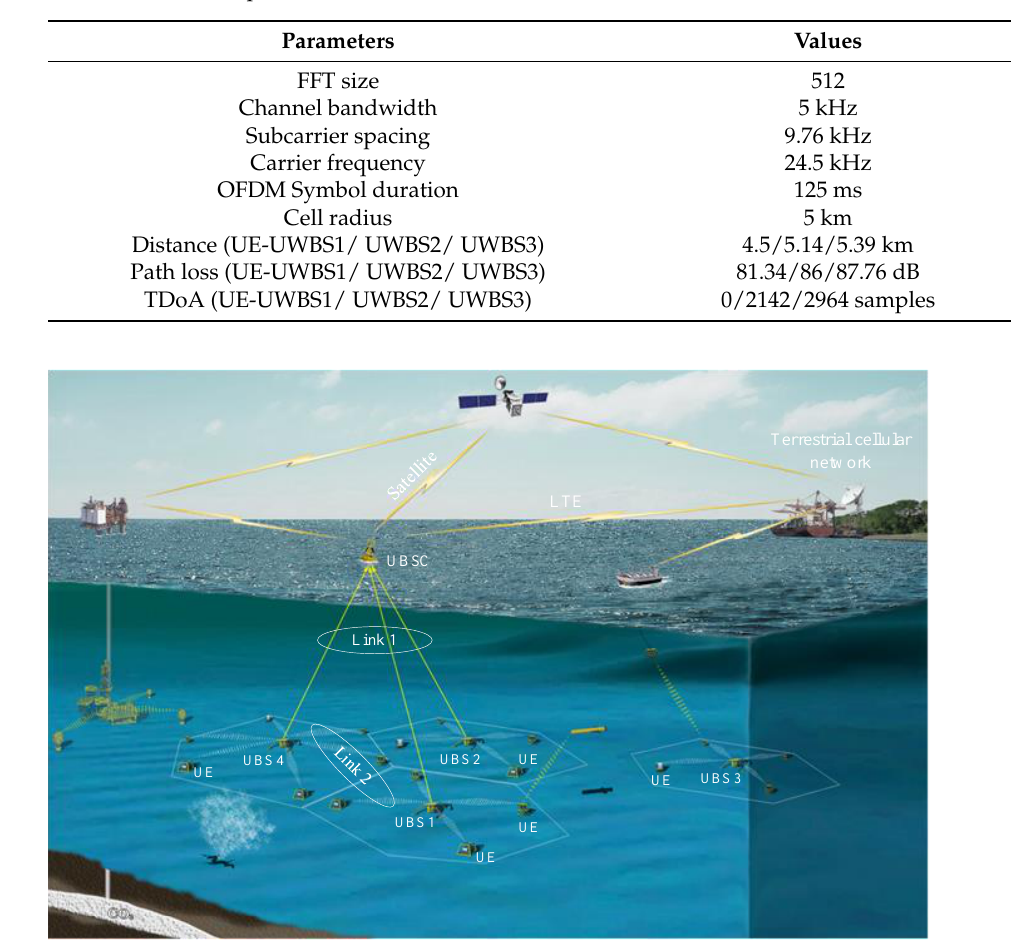
Figure 7. Design of UWAC cellular